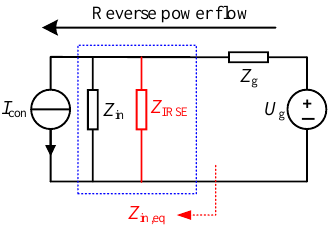
Figure 9. Equivalent circuit under IRSE control in reverse power direction.